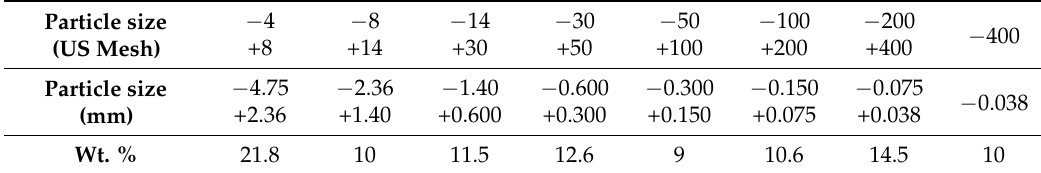
Table 1. Size distribution of coke particles.